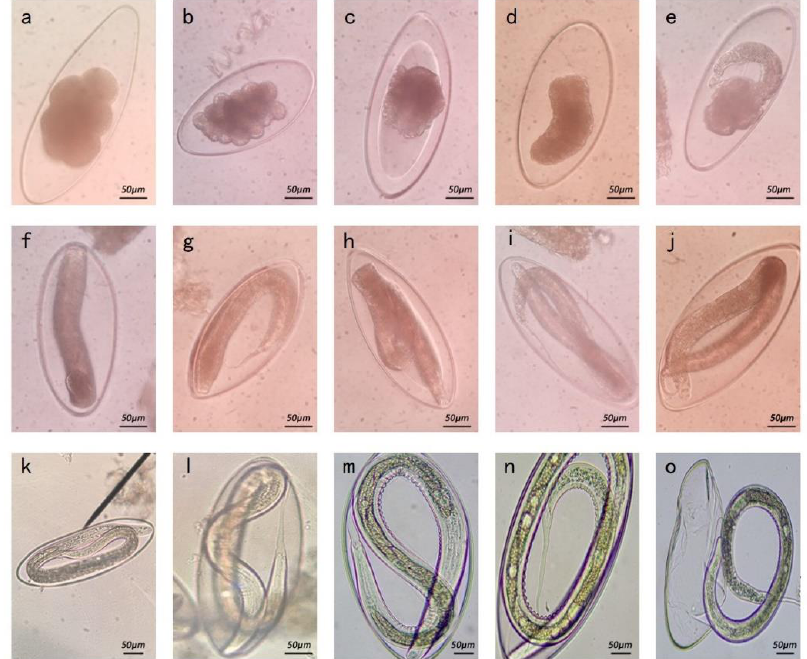
Figure 3. Development process of Nematodirus spp. ( a ) Each egg contained several egg cells, and the gap between the egg cells and the shell was large (400×). ( b ) Egg cells dividing (400×). ( c – d ) Egg cells begin to fuse (400×). ( e ) Embryo entering the tadpole stage (400×). ( f – g ) L1 larva forming (400×). ( h – j ) L1 larvae developing (400×). ( k ) L2 larva forming (250×). ( l ) L2 larva developing (400×). ( m – n ) The larva gradually developing into L3 larva (250×). ( o ) The larva hatching into mature L3 larva (100×). The tails of the L3 of different Nematodirus species vary in their typical characteris- tics [17]. Microscopic observation of the morphology of third-stage larvae of the isolated strains indicated that the tail had an angular gap, and the worm had a thin spicule in the center (Figure 4). This is generally similar to the tail-end morphology of the larvae of several common species of Nematodirus [18]. Based on egg size and larval and adult morphology, the isolated strain was initially identified as Nematodirus oiratianus ( N. oiratianus ).